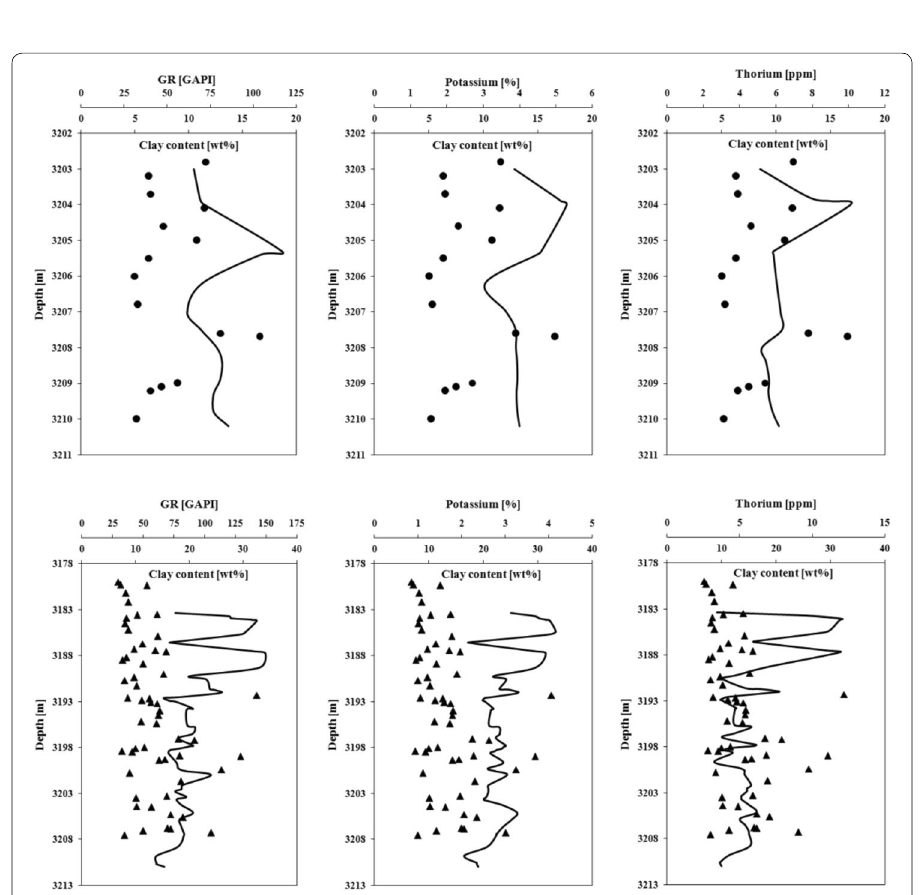
Fig. 4 The Shurijeh GR, K, THOR data vs core-measured clay minerals contents as a function of depth. Black circle Gas producing well data points, black up-pointing triangle non-producing well data